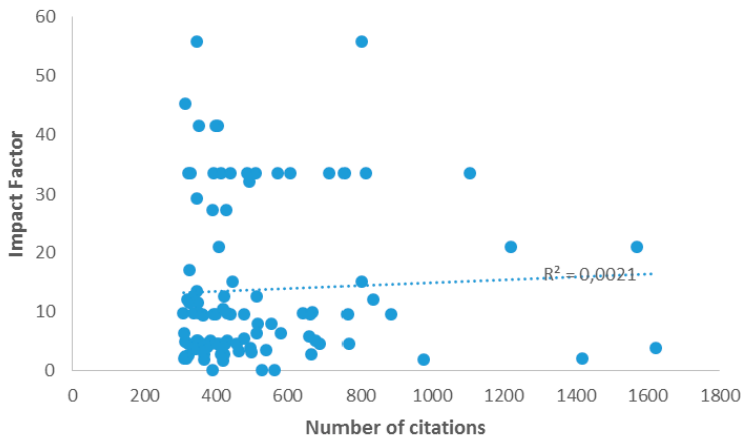
Figure 3. Linear correlation between number of citations of articles included in the top 100 list and impact factors of journals where papers were published.